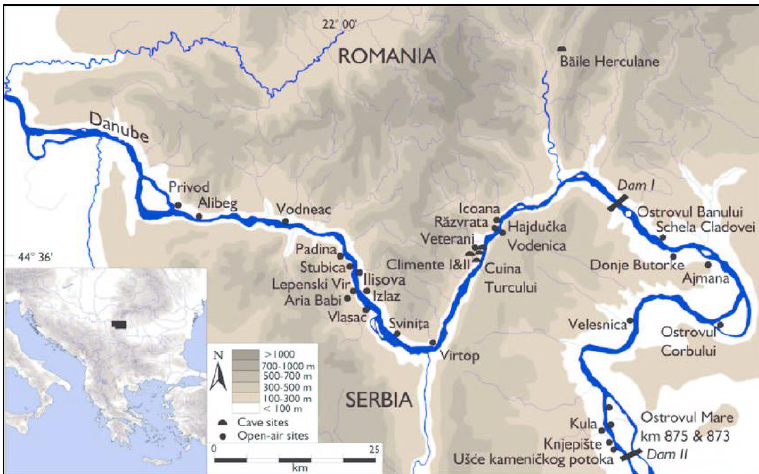
Figure 10. A map that best illustrates how water flows have had a decisive influence on the development of human settlements and more permanent character settlements. Even today, nomadic tribes, whenever possible, move during the migration along the river. All the sites on this map are on the bank of the strong river, Danube, and Lepenski Vir is slightly more upstream, which could have more easily impacted its downstream neighbours.